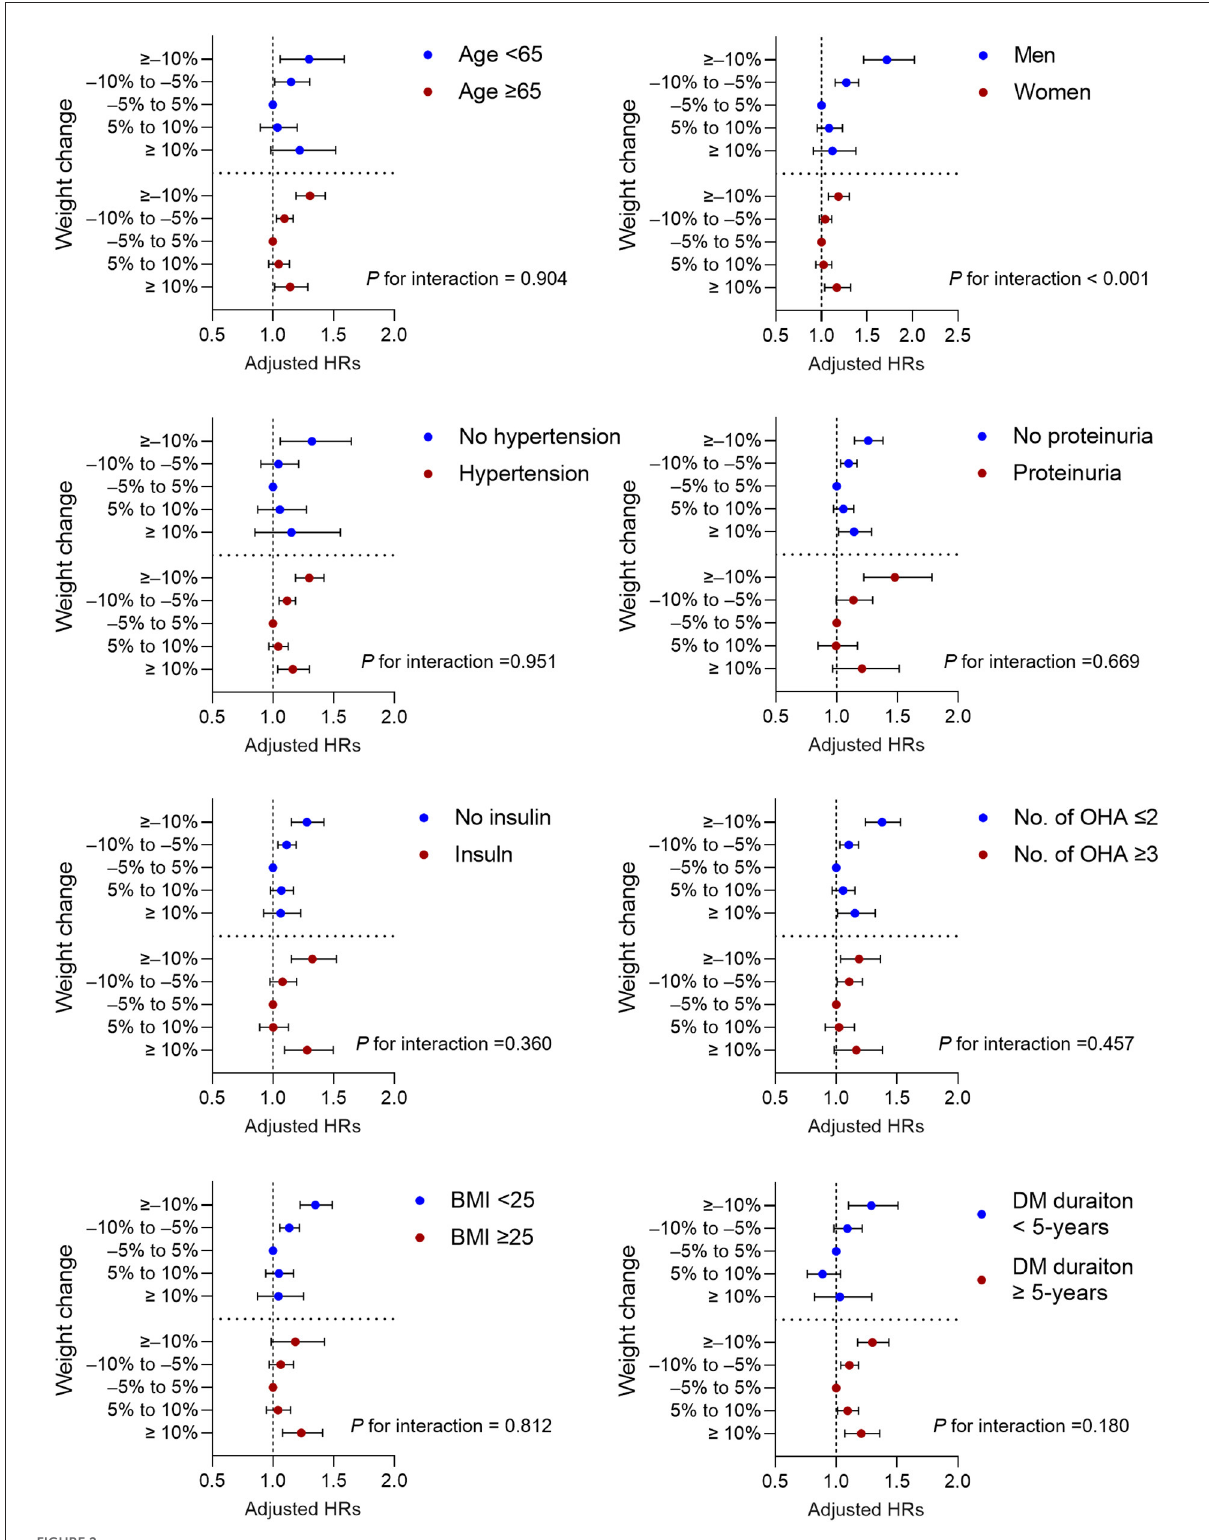
FIGURE2 Subgroup analysis for adjusted hazard ratios (HRs) of incidence any fracture. Horizontal lines represent the range for 95% confidence intervals. Models were adjusted for age, sex, smoking, alcohol consumption, regular exercise, income status, use of insulin, more than three classes of oral hypoglycemic agents, diabetes duration, previous histories of hypertension, dyslipidemia and end-stage renal disease, and previous body weight. OHA, oral hypoglycemic agents; BMI, body mass index; DM, diabetes